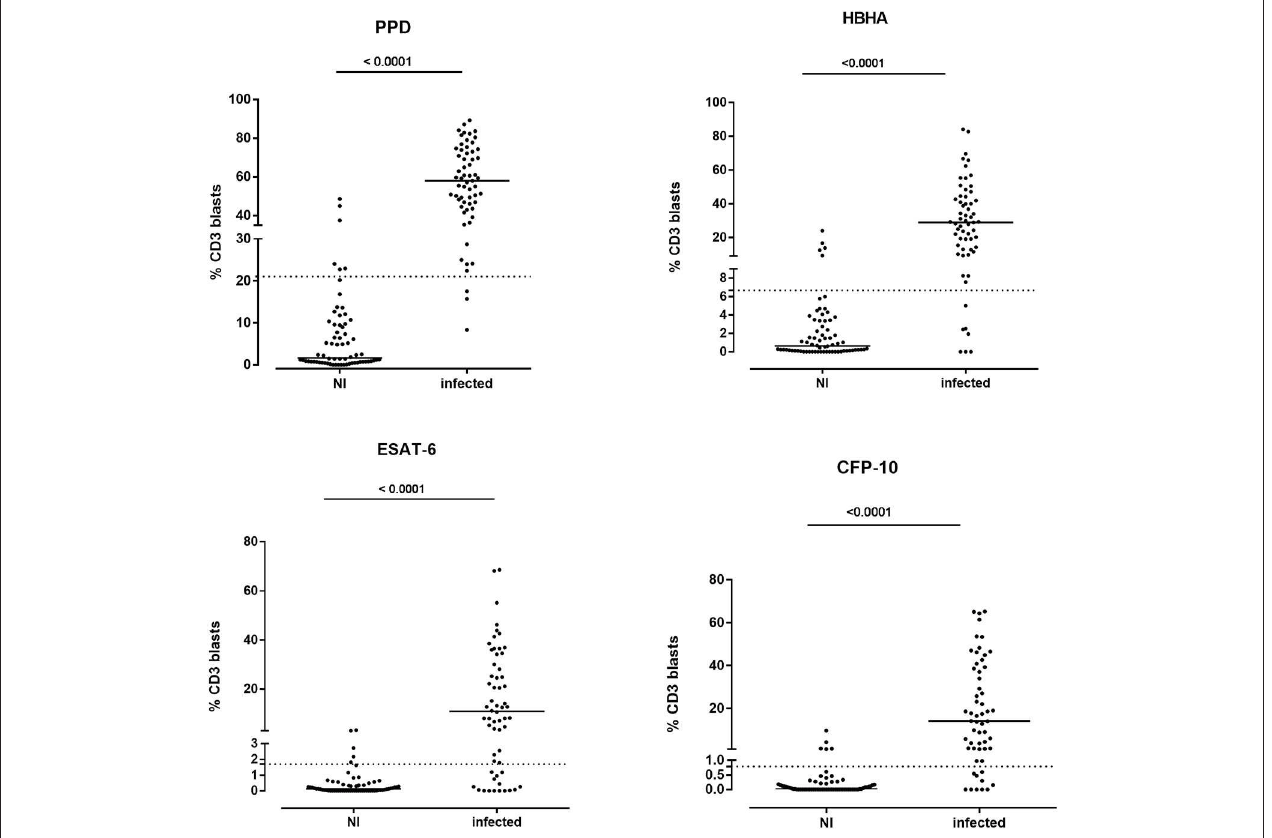
FIGURE 2 | Percentages of CD3 + blasts induced by mycobacterial antigens in M. tuberculosis -infected and in non-infected children. Ten-fold diluted whole blood was incubated during 7 days at 37 ◦ C with PPD (4 µ g/ml), HBHA (10 µ g/ml), ESAT-6 (10 µ g/ml), or CFP-10 (5 µ g/ml), as indicated, before labeling the cells with anti-CD3 monoclonal antibody and analysis of the percentages of CD3 + blasts by flow cytometry. Each symbol represents the value from an individual subject after deduction of the percentage obtained in non-stimulated condition, and the horizontal lines indicate the medians. The dotted horizontal lines indicate the cut-off values determined by ROC curve analysis. Values obtained for non-infected (NI) children were compared to those from infected children (LTBI/aTB) by Mann-Whitney U